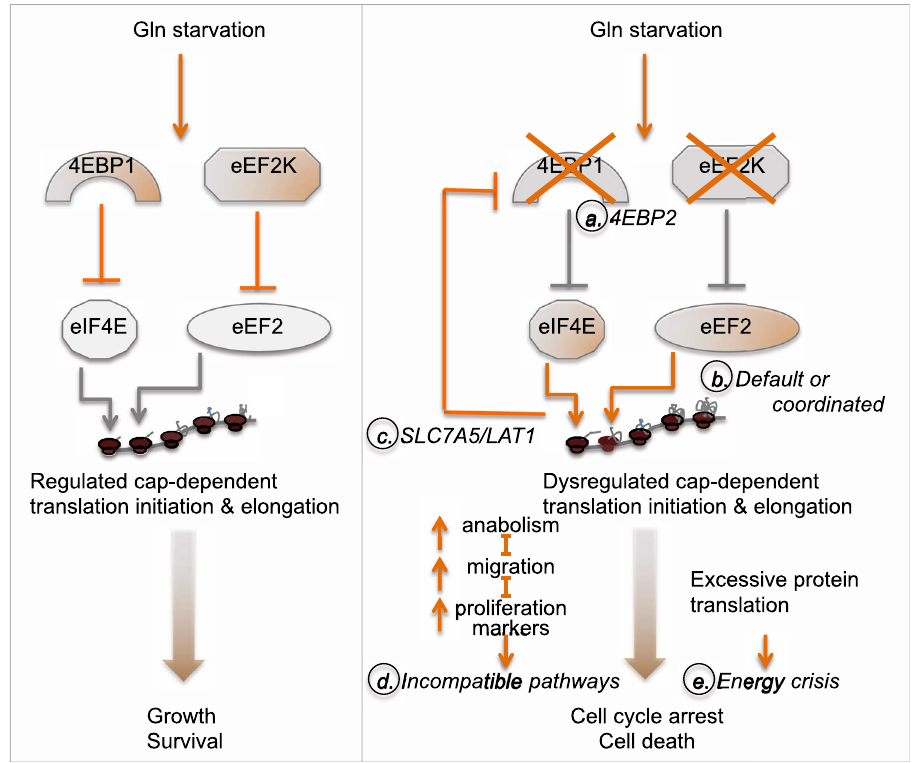
Figure 7. A working model for the effect of eEF2K and 4EBP1 on protein translation and cell growth/survival. Left, under glutamine starvation, eEF2K and 4EBP1 attenuate protein translation allowing cells to adapt to nutrient deprivation without loss of viability. Right, eEF2K and 4EBP1 inhibition enforces enhanced protein translation initiation and elongation, leading to cell cycle arrest or death. The model raises several questions and predictions (a–e)—see text for